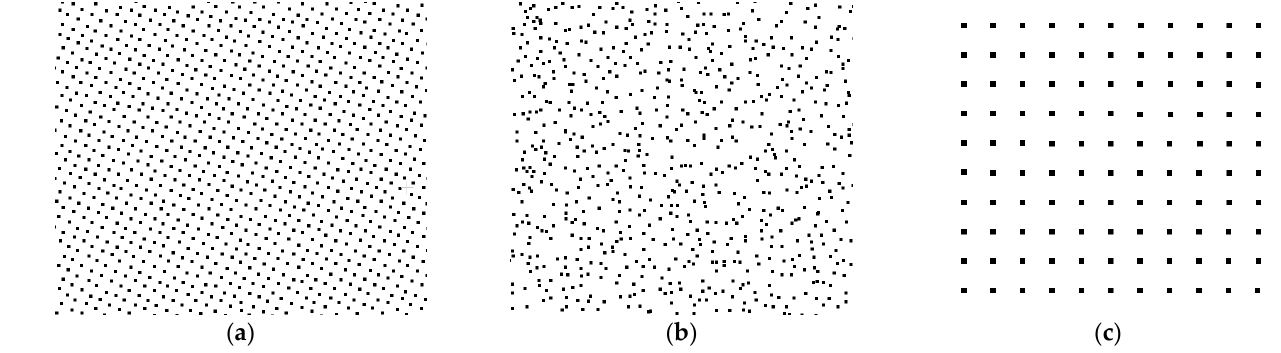
Figure 8. Point cloud structure: iOS resolution 1 cm ( a ), iOS resolution ~1.5 cm ( b ), Android resolu- tion 2 cm ( c ).